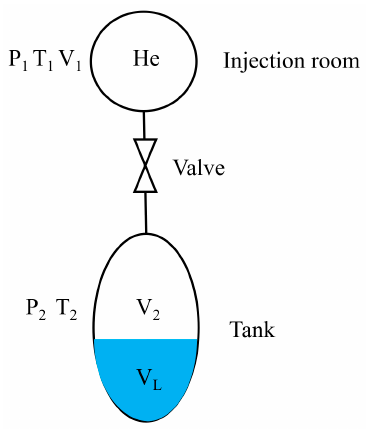
Figure 1. Schematic of the PGS method.